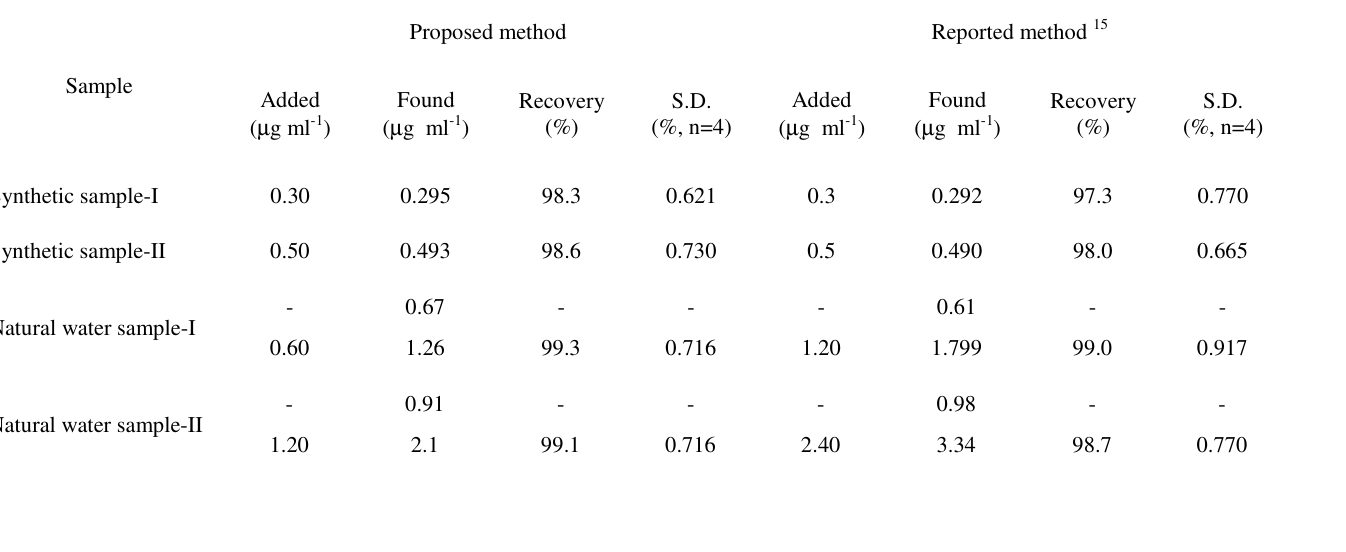
Table. 3. Analytical results of chromium determination in water samples around